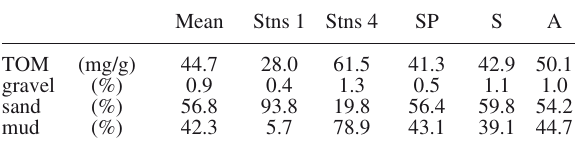
t aBle 2. – Relative abundances of benthic foraminiferal taxa and assemblage parameters. SP, spring; S, summer; A, autumn;